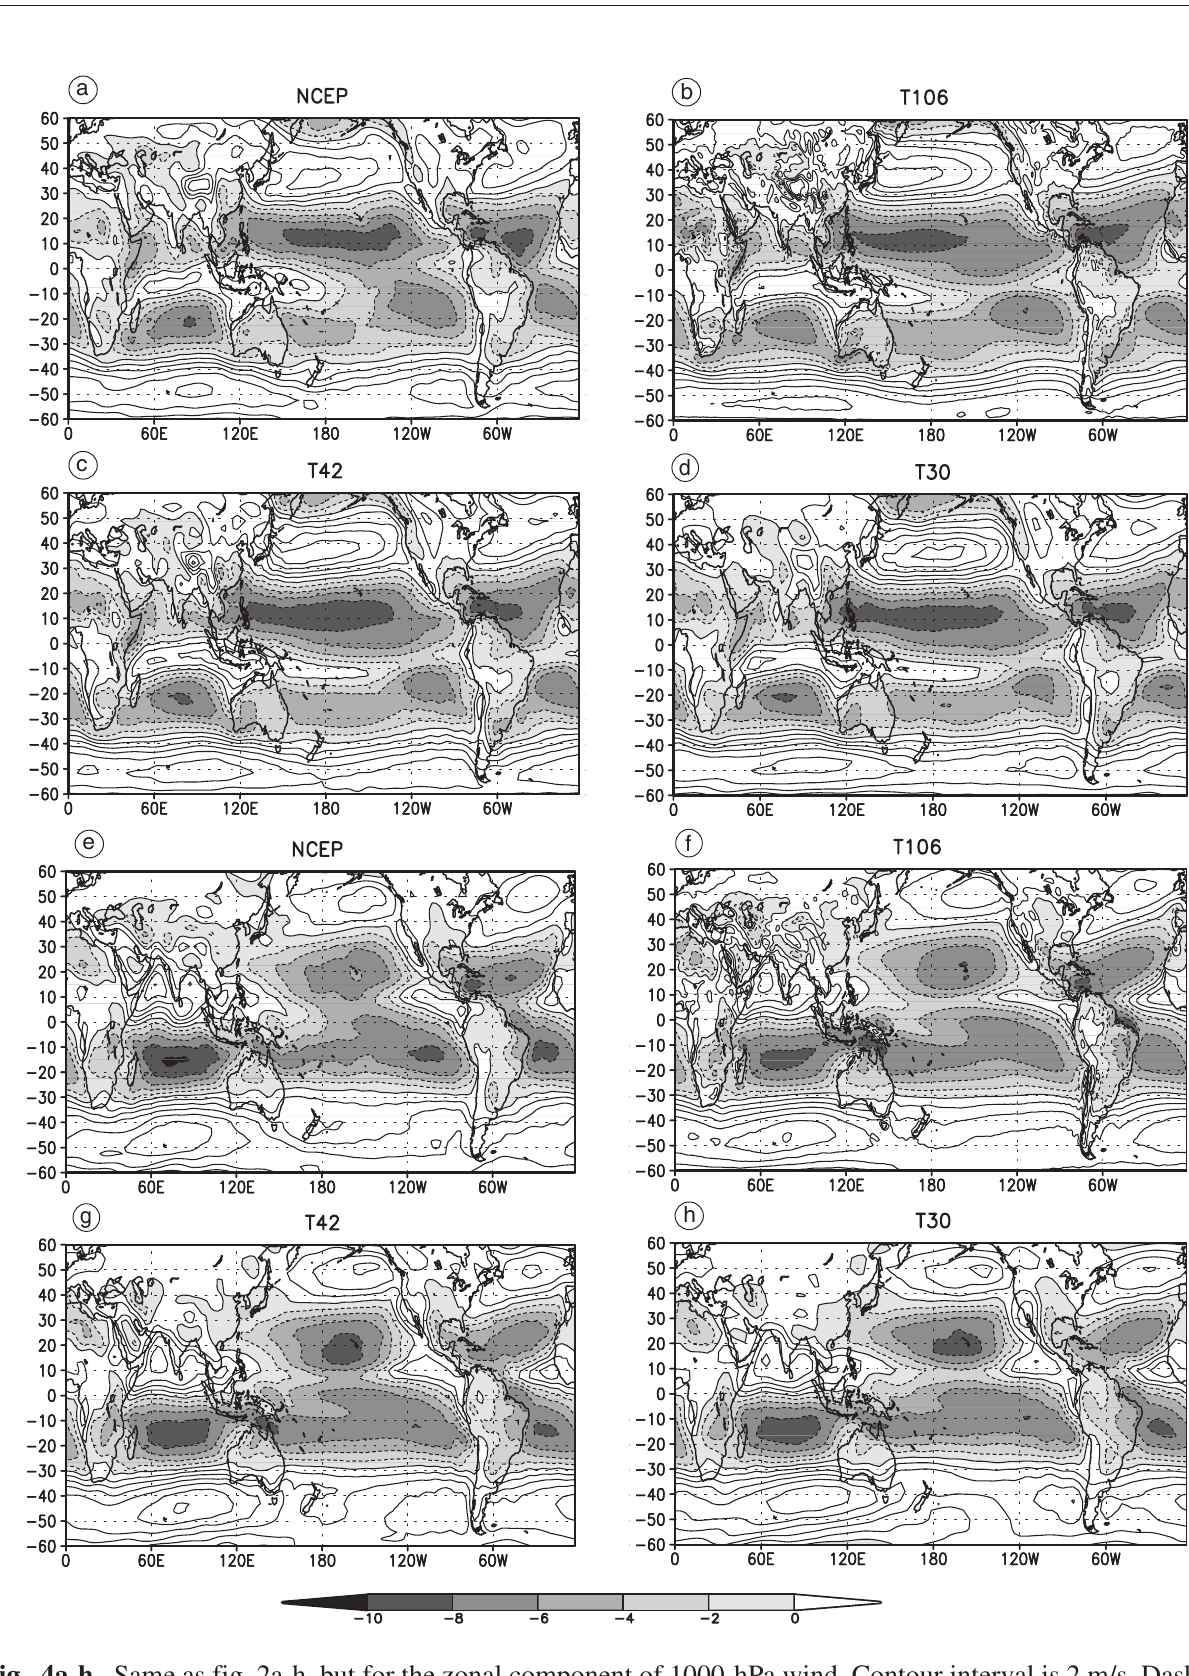
Fig. 4a-h. Same as fig. 2a-h, but for the zonal component of 1000-hPa wind. Contour interval is 2 m/s. Dashed contour lines and shaded areas indicate negative